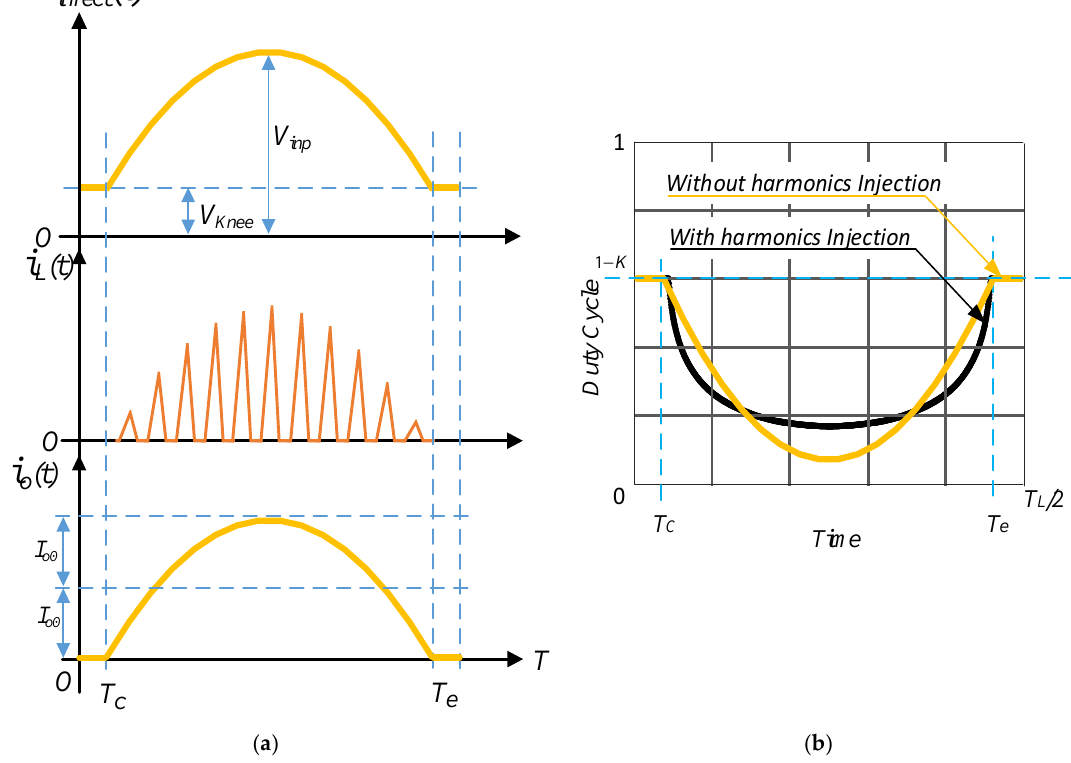
Figure 4. LED driver based buck converter for E-Cap less waveforms with and without harmonics injections. ( a ) Sketch for the rectified input voltage ( v inrect ( t )) and inductor current ( i L ) without harmonics injection. ( b ) The Duty cycle shape with and without harmonics injection.